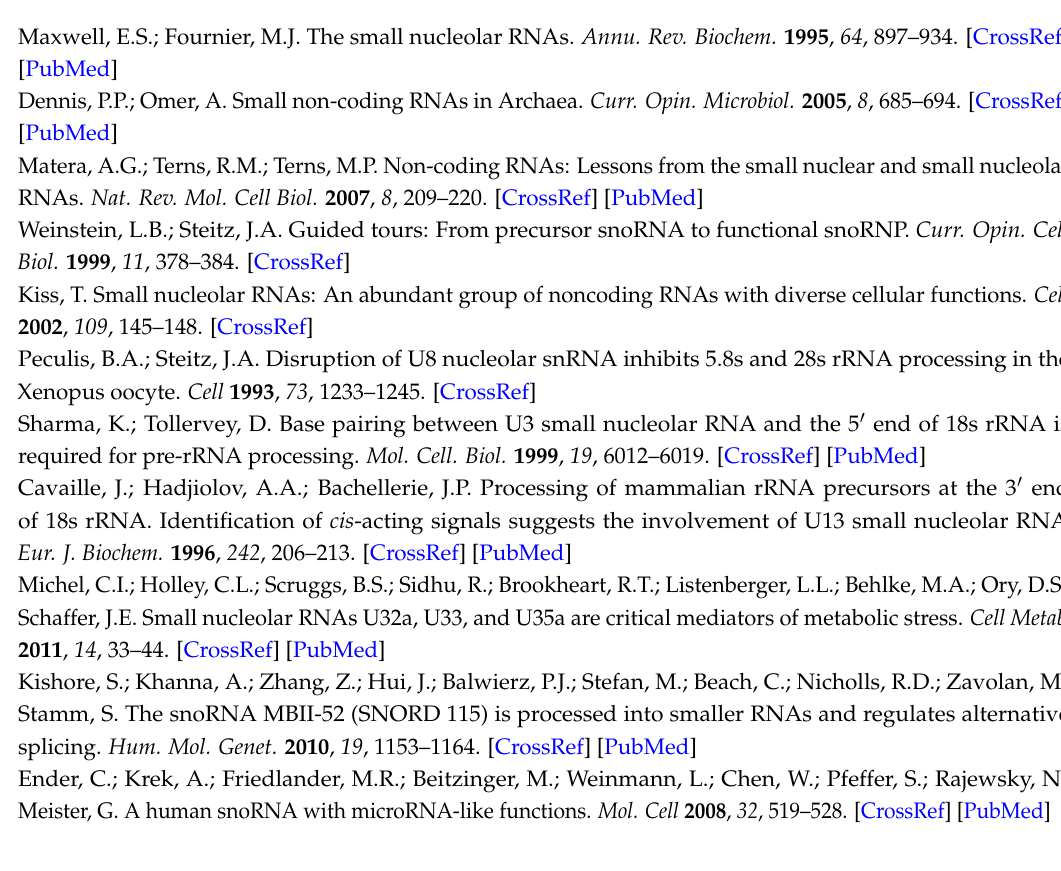
Table S1: Primers used for construction of plasmids; Table S2: Used small interfering RNAs (siRNAs); Table S3: Primers used for chromatin immunoprecipitation (ChIP); Table S4: Putative targets of U3snoRNA segments functioning as microRNA (miRNA); Figure S1: Indication of apoptosis by U3snoRNA knockdown; Figure S2: Promoter activity of the isolated U3-, U8-, and U13snoRNA gene promoters in comparison to that of the SV40 early region. The original images for all the gels presented in this work can be found in a separate supplementary PDF file at www.mdpi.com/2311-553X/2/4/11/s2. Author Contributions: All authors designed the experiments and analyzed the data; Hala Ismael performed the experiments; Hala Ismael and Hans Stahl wrote the